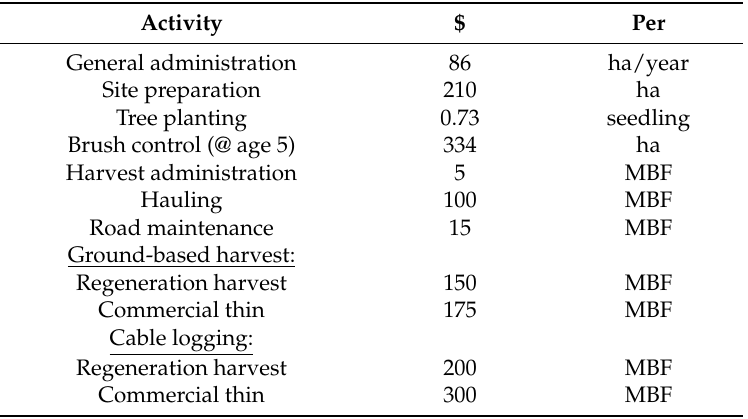
Table 3. Management